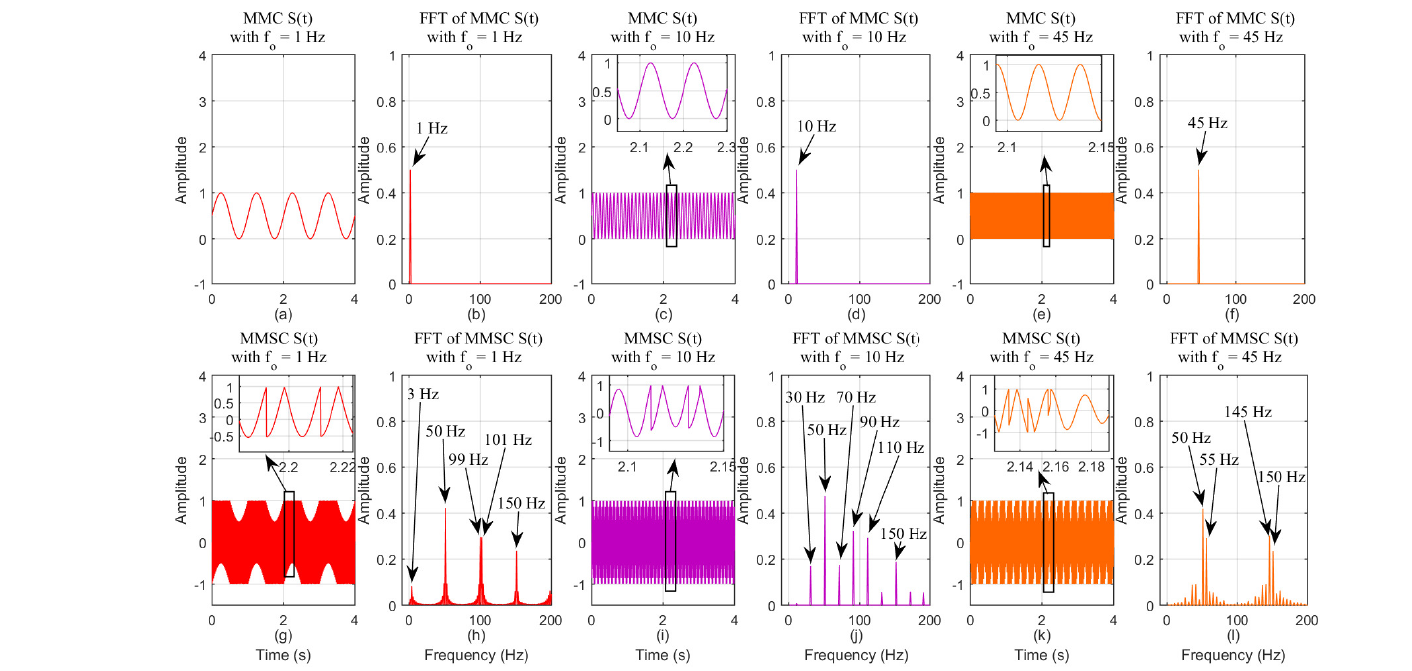
Figure 2. ( a , c , e ) show the MMC insertion-index signal ( S ( t ) ) for the cases in which f o = 1,10 and 45 Hz, respectively. ( b , d , f ) show the FFT of the signals shown in ( a , c , e ), respectively. ( g , i , k ) show the MMSC insertion-index signal ( S ( t ) ) for the cases in which f o = 1,10 and 45 Hz, respectively. ( h , j , l ) show the FFT of the signals shown in ( g , i , k ), respectively.